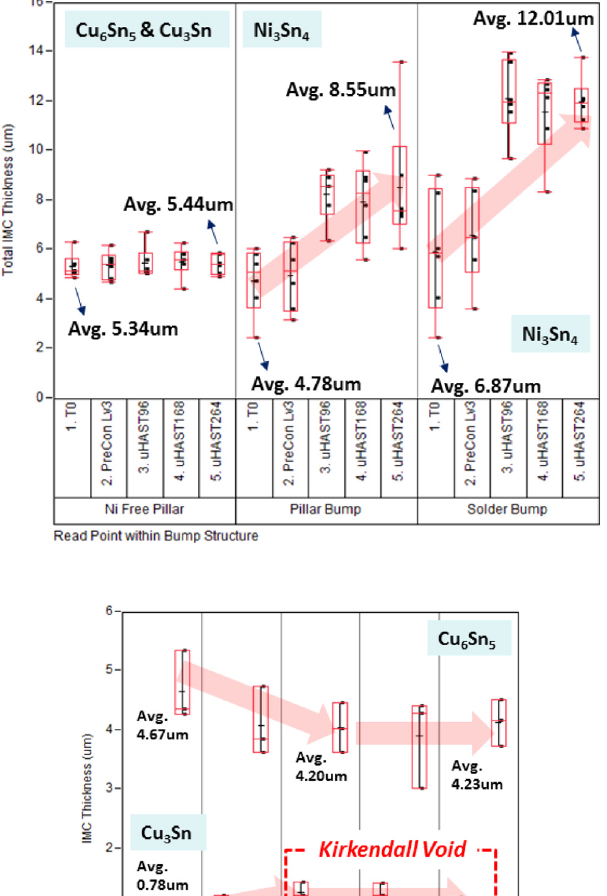
Figure 10. Cu 6 Sn 5 and Cu 3 Sn IMC thickness under uHAST stress